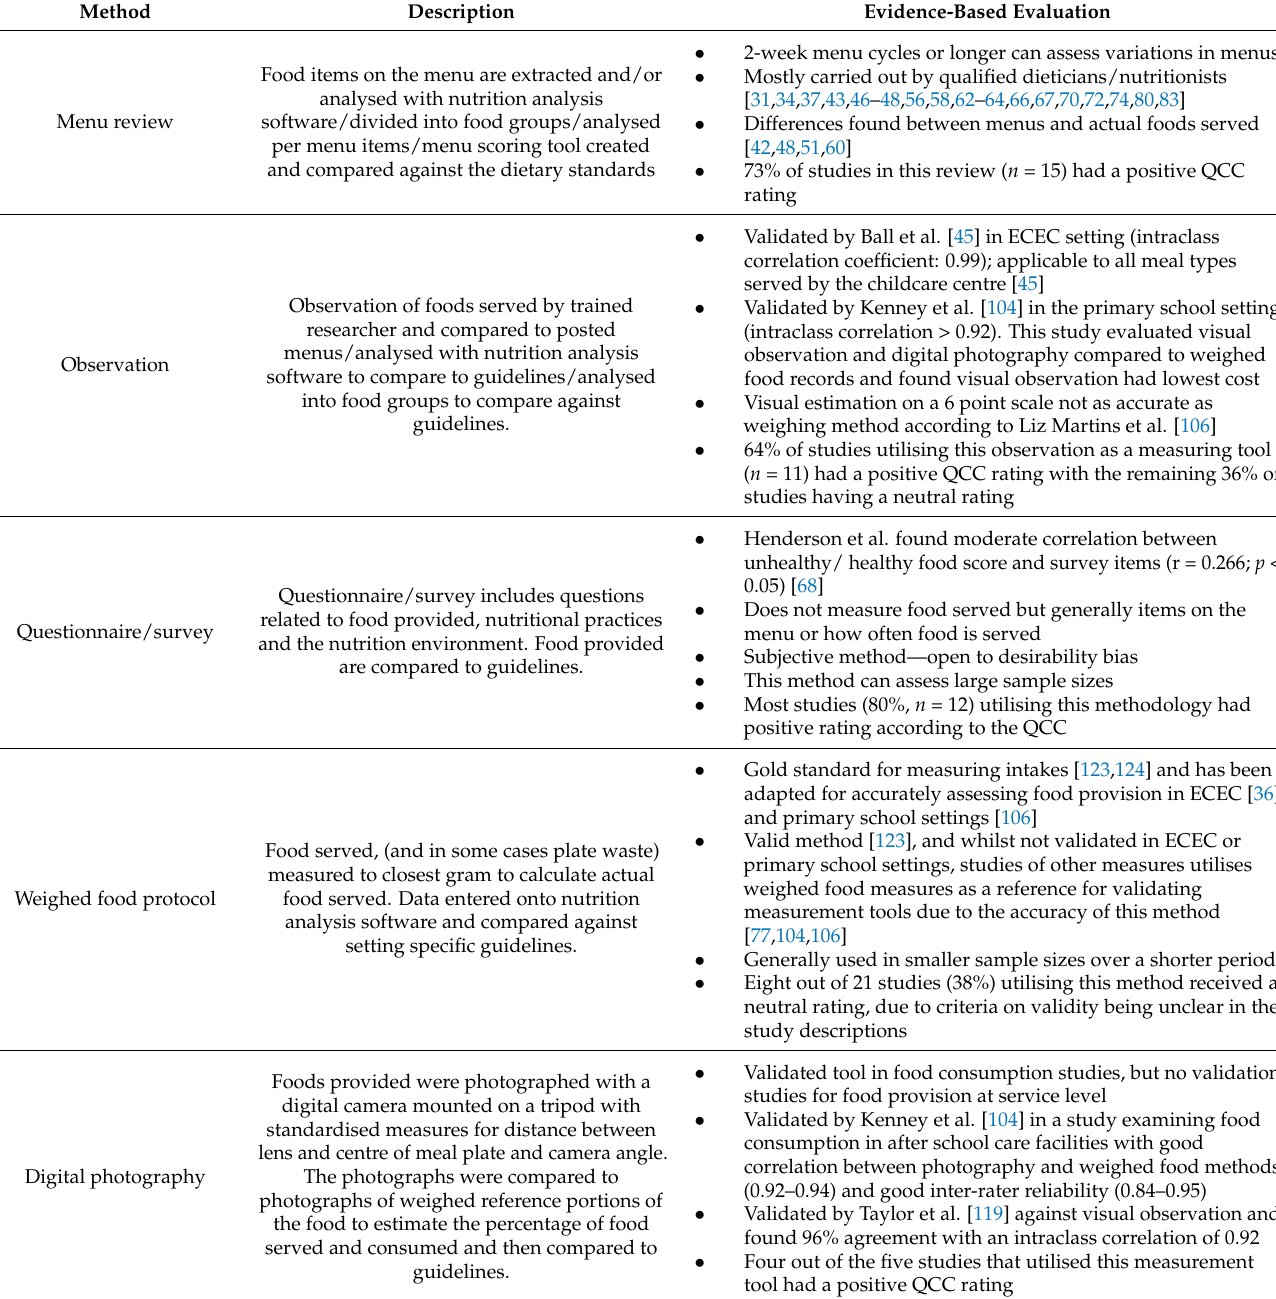
Table 3. Evidence-based evaluation of measurement tools for assessing food provision and menu compliance in ECEC and primary school